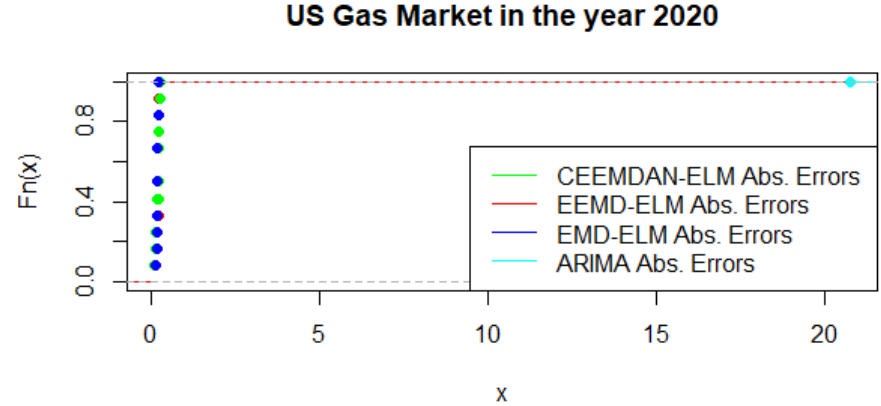
Figure 17. Empirical cumulative distribution function of US gas in